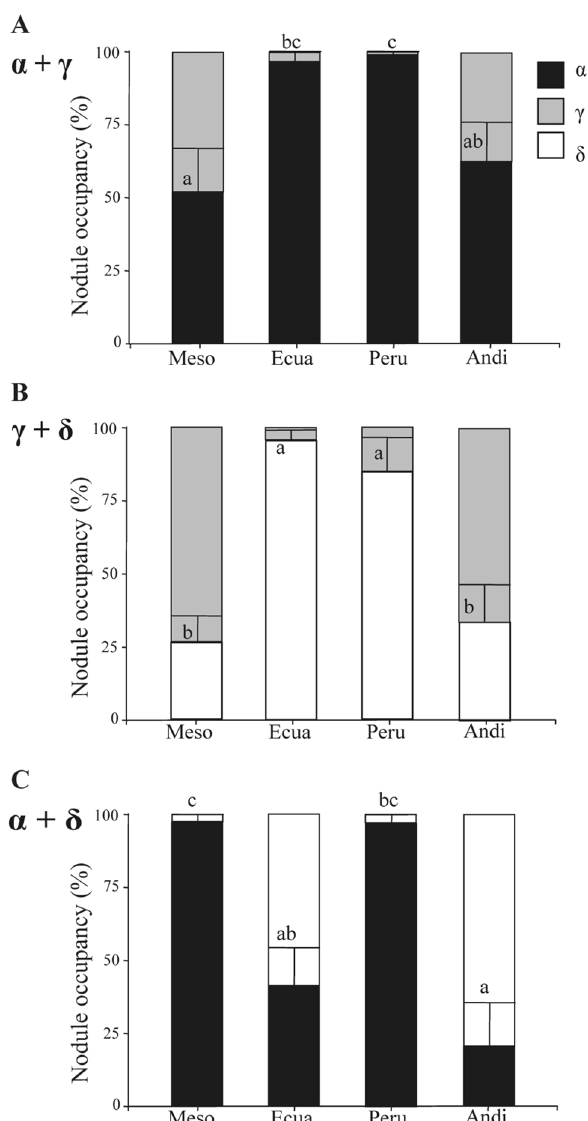
Figure 2. Nodule occupation by R. etli strains nod C types co-inoculated in bean plants representative of the Mesoamerican (Meso), Ecuadorian (Ecua), Peruvian (Peru), and Andean (Andi) gene pools. Nodule occupancy was defined as the proportion of nodules occupied by each R. etli strain nod C type, α (black bars), γ (gray bars) or δ (white bars), co-inoculated with a 1: 1 ratio in the following combinations: α with γ ( A ), γ with δ ( B ) and α with δ ( C ). The data are combinations of three independent co-inoculation experiments in which at least two plants of each accession were individually inoculated with a mixture of strains. Statistical analyses were performed with nonparametric Kruskal–Wallis H test. Letters represent groups significantly different ( p < 0.05) from each other. Bars indicate standard